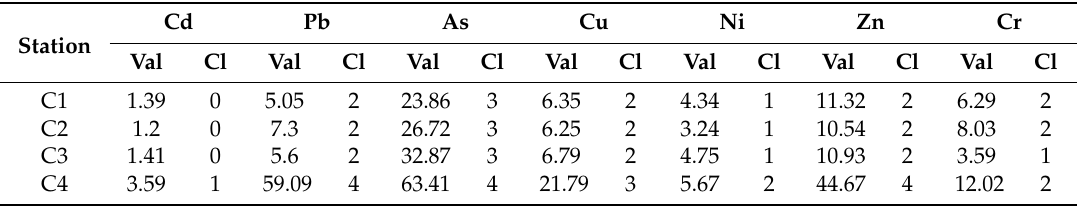
Table 4. EF and associated enrichment classes of Cd, Pb, As, Cu, Ni, Zi and Cr at the C1, C2, C3 and C4 stations (Val = Value and Cl = Class).